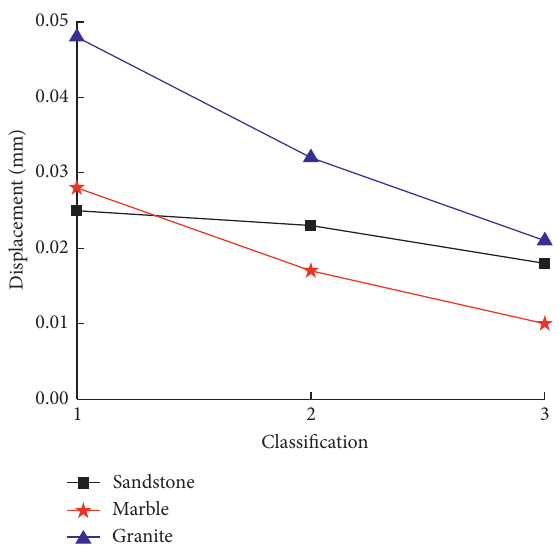
Figure 7: Creep increment curve before and after fatigue